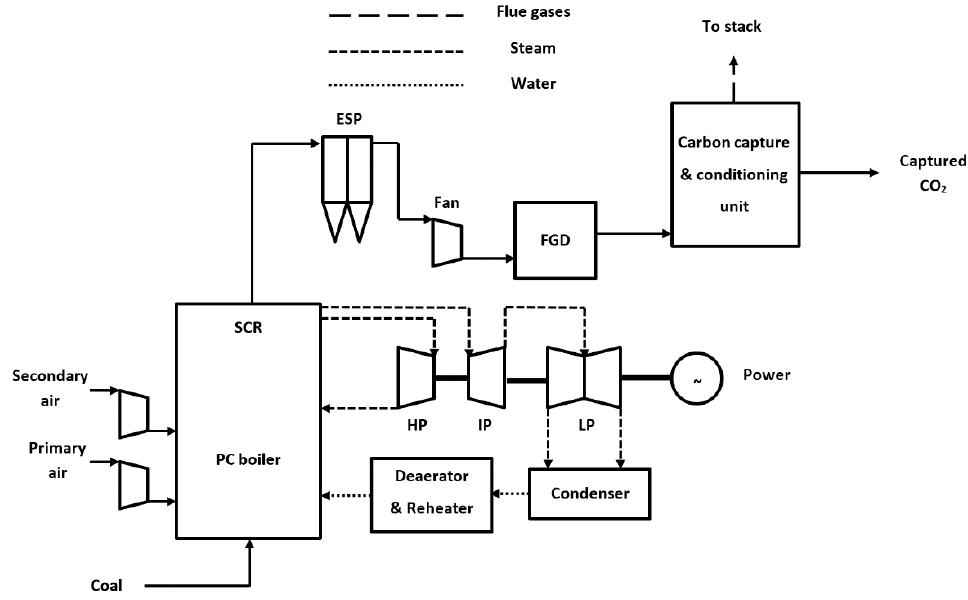
Figure 6. Layout of decarbonized coal-based super-critical power plant.